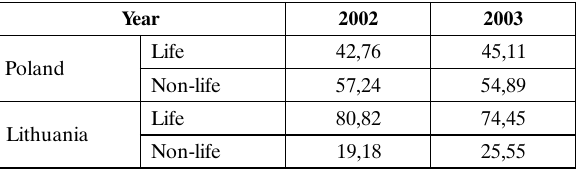
Table 9. Structure of premiums (life and non-life) in Poland and Lithuania, in 2002–2003, life and non-life sectors